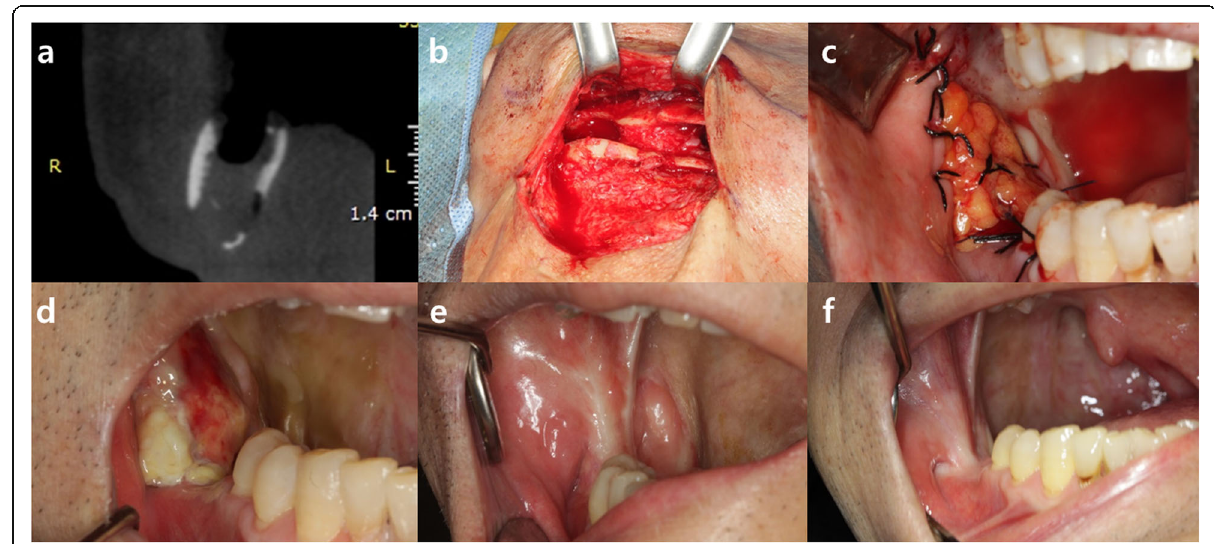
Fig. 2 a CT view showing continuous state of osteonecrosis on the mandibular body and angle. b Large intra-oral surgical defect connecting the oral cavity and affected mandibular bone on the retromolar region was seen after the removal of inflamed tissue. c The BFP flap perfectly covered the intra-oral defect without tension, and flap was sutured to marginal oral mucosa with 3-0 black slik. d , e , f Re-epithelization of the grafted buccal fat pad after operation was seen ( d 4-week, e 6-month, f 1-year